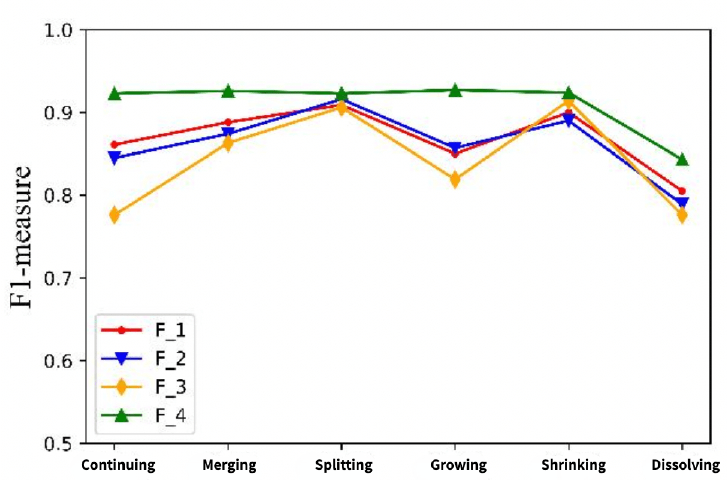
Figure 9. Enron dataset prediction